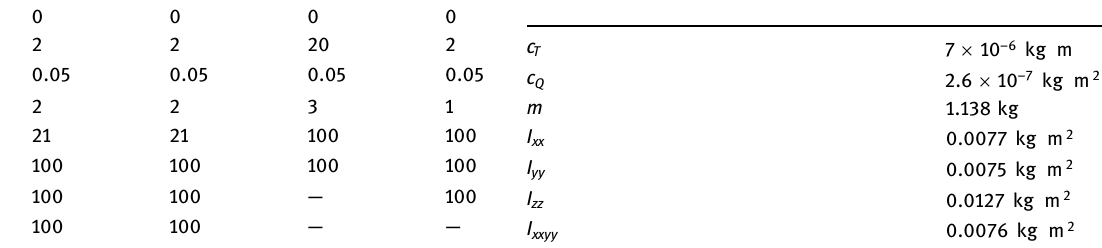
Table 3: Unknown nominal values of dynamic model parameters